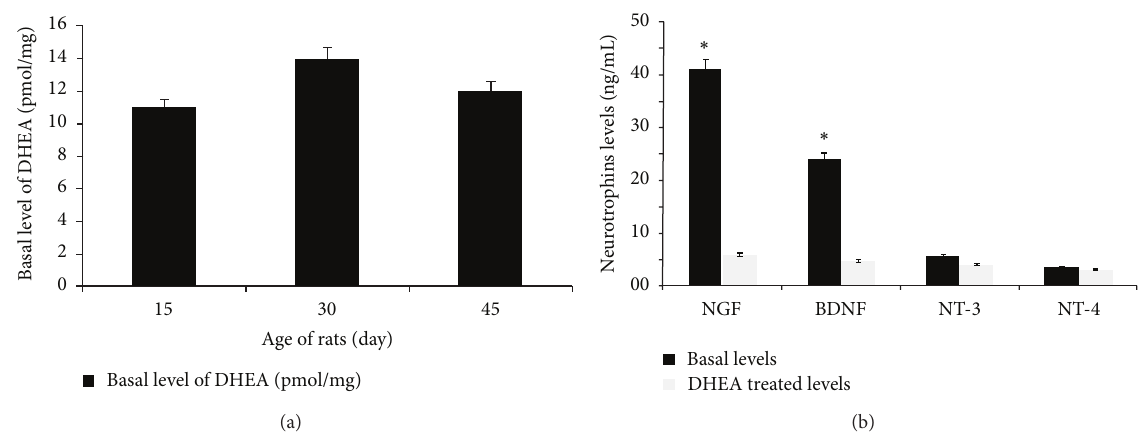
Figure 1: Mean basal levels of DHEA of 15–30–45-day old Wistar rats (a). Mean basal levels of NGF, BDNF, NT-3, and NT-4 neurotrophins in the brain cortex of 30-day old Wistar rats and Mean levels of neurotrophins after DHEA treatment in the brain cortex of Wistar rats. A comparison between basal levels of NGF, BDNF, NT-3, and NT-4 neurotrophines before and after DHEA treatment in the brain cortex of Wistar rats. The levels of NGF, BDNF, NT-3, and NT-4 neurotrophines were measured using ELISA (b). In each part, the data are obtained from nine